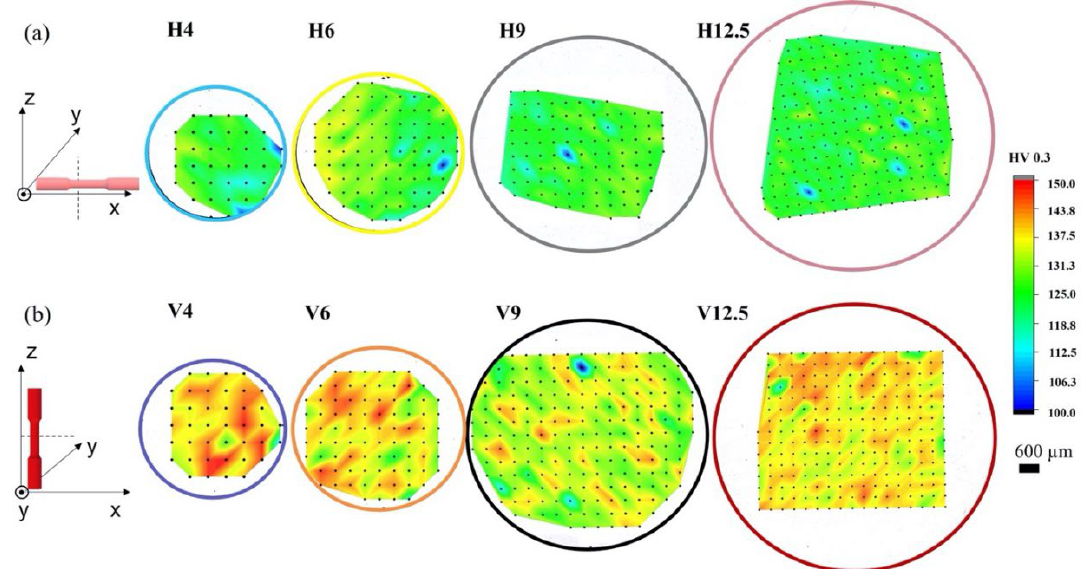
Figure 6. Colour contour maps representing Vickers micro-hardness (HV) values of the cross-sections (planes perpendicular to the tensile loading direction) of the specimens with various size parameters, oriented ( a ) Horizontally and ( b ) Vertically in the AM build. Black marks represent the indents on the respective samples.